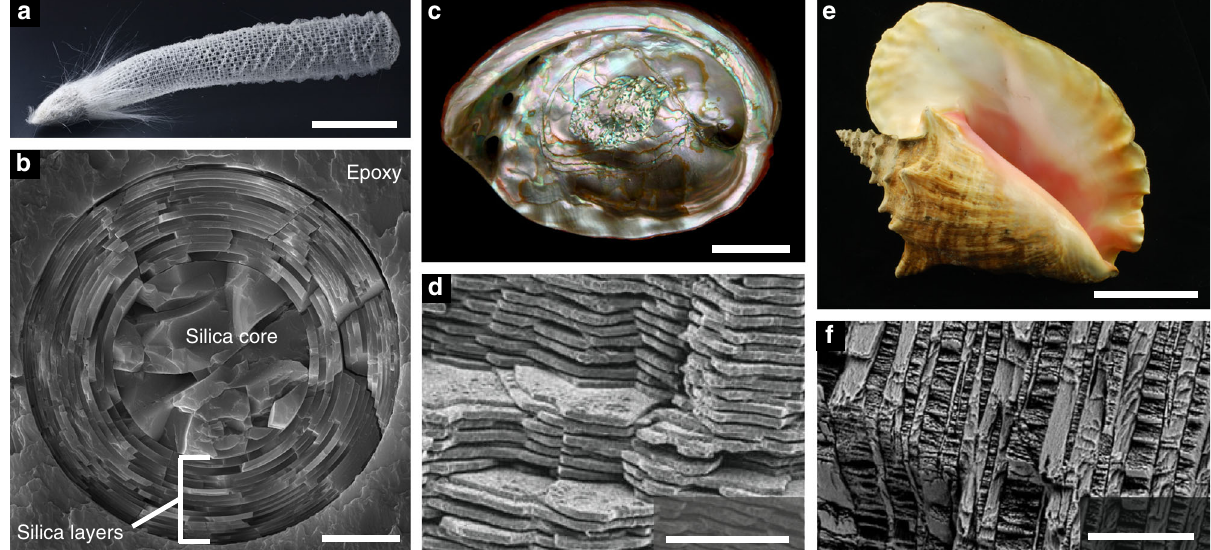
Fig. 1 Examples of the layered architecture in SBMs. a Skeleton of a Euplectella aspergillum sponge (modi fi ed from 16 copyright 2015, The National Academy of Sciences). b Concentric silica layers make up the cylindrical layered architecture of anchor spicules from E. aspergillum (modi fi ed from 16 copyright 2015, The National Academy of Sciences). c The iridescent shell of Haliotis rufescens (courtesy of John Varner). d The brick and mortar layered architecture of nacre consisting of staggered aragonite tablets (modi fi ed with permission from 65 copyright 2012, the Royal Society of Chemistry). e The shell of the queen conch ( Strombus gigas ) (courtesy of John Varner). f The crossed-layered architecture of the S. gigas shell, which consists of layers of aragonite (modi fi ed with permission from 66 copyright 2014, Elsevier). Scale bars: a ≈ 5 cm; b 10 μ m; c ≈ 2 cm; d 10 μ m; e ≈ 10 cm; f 100 μ